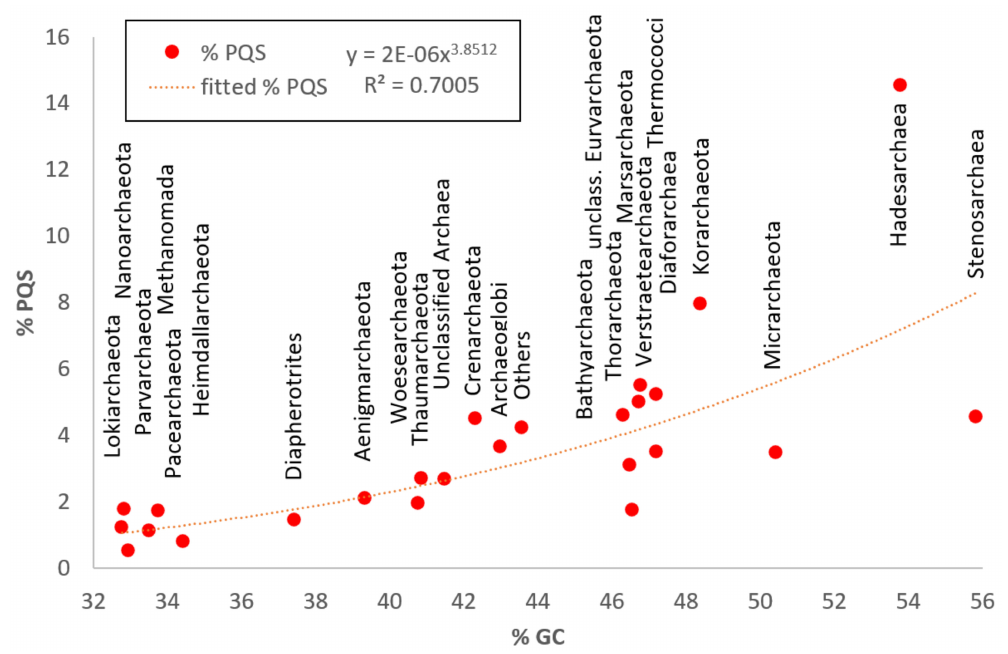
Figure 7. Relationship between GC percentage and % of PQS in genomes of particular archaeal subgroups. The Fitted equation with the R 2 coe ffi cient is depicted on the top side of the